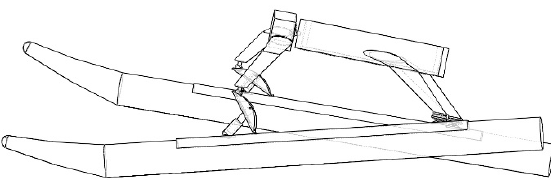
Figure 3. Articulated structure of multi-degree of freedom.